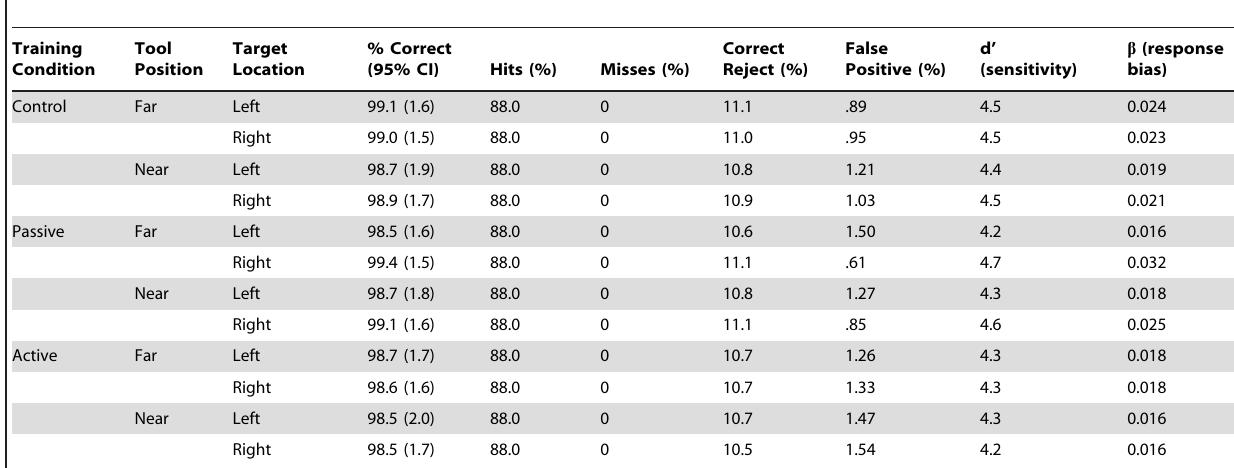
Table 1. Measures of performance accuracy (percent correct), sensitivity (d’), and response bias ( b ) in the visual detection task.